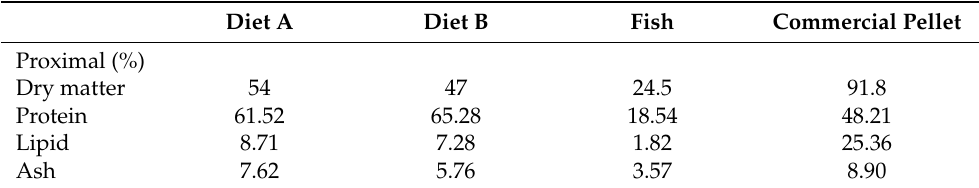
Table 2. Proximate composition of different diets that were used to feed S. lalandi broodstock during the spawning period